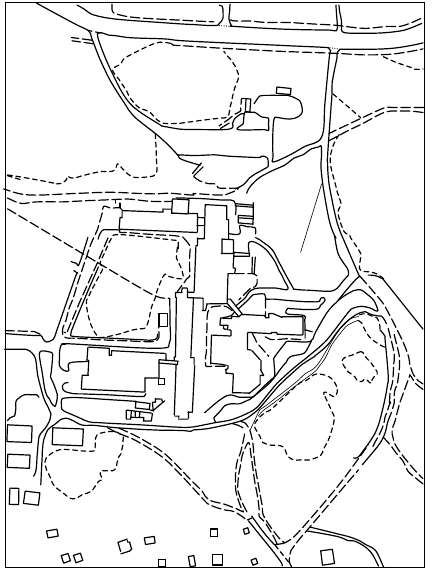
Fig 3. Fragment of stereoscopic plotting